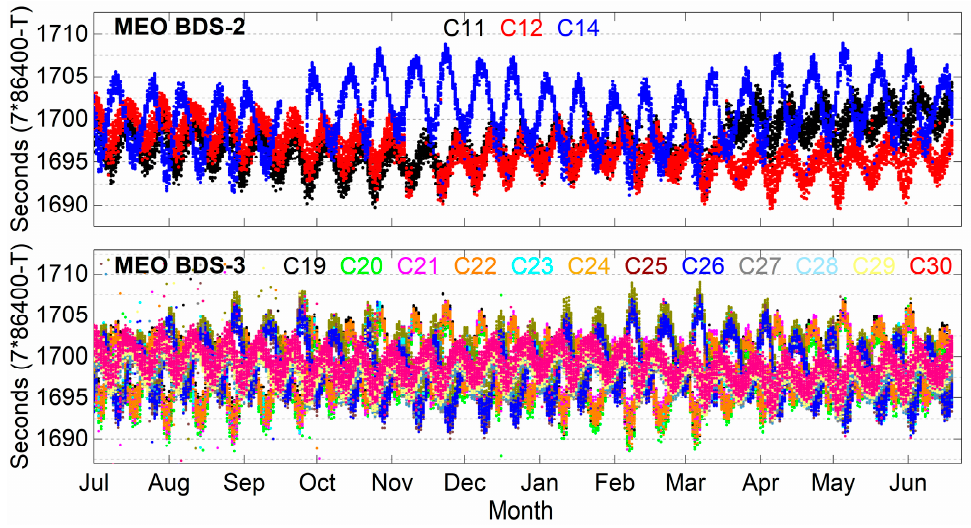
Figure 3. The time shifts of BDS-2/BDS-3 MEO ORTs.